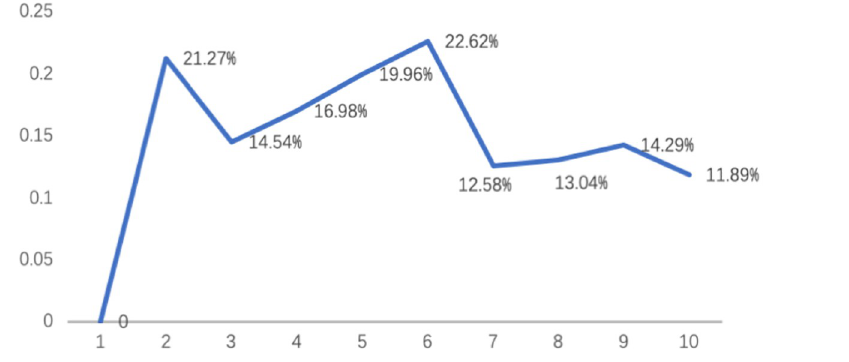
Fig 4. Agglomeration coefficients increased percentage for the last 10 times.